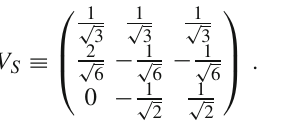
Table 3 Numerical values of parameters and output of CKM parameters at the best-fit point